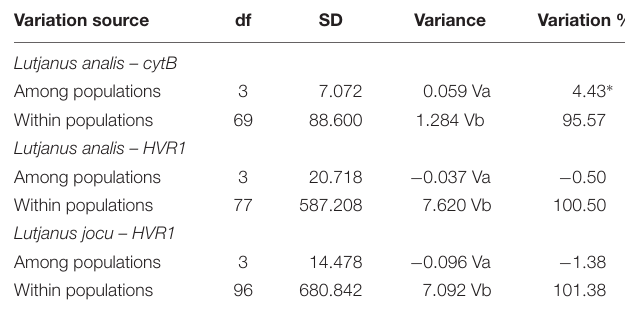
TABLE 4 | Analysis of molecular variance (AMOVA) of Lutjanus analis and Lutjanus jocu, based on F st indices among the different sample